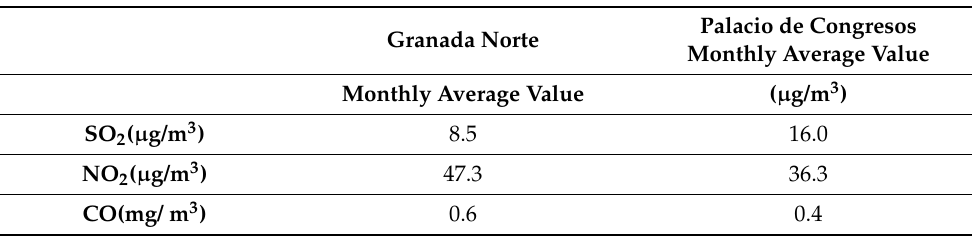
Table 2. Monthly average values for pollutants SO 2 , NO 2 and CO measured in two locations of the city of Granada during the study period.